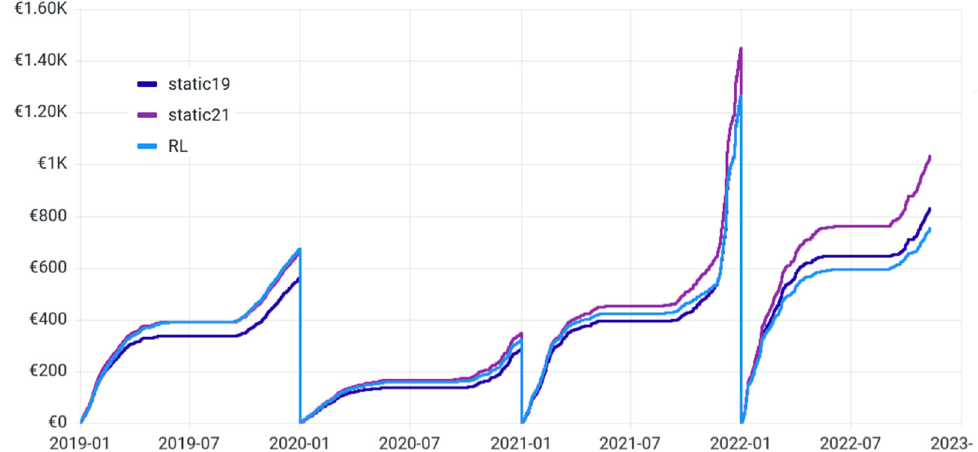
Figure 6. Cumulative energy cost for each simulation year for a 2001–2010 building. Table 4. Average cost savings from the baseline (21 °C) per simulation year.